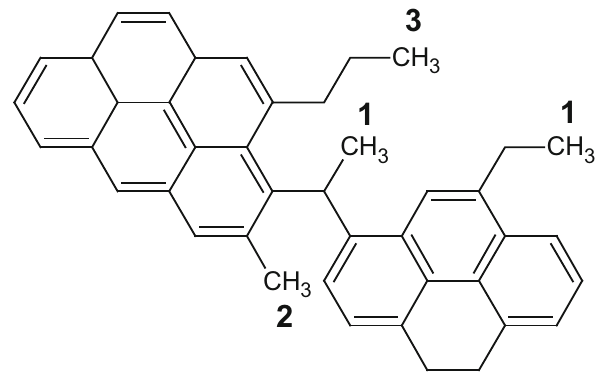
Fig. 9 Segmental structure of coal for illustrating different kinds of methyl groups